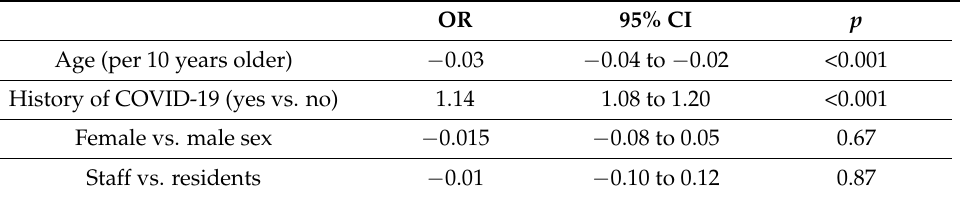
Table 2. Linear regression analysis of factors associated with IgG ‐ S titers (logAU/mL) after vaccina ‐ tion against SARS ‐ CoV ‐ 2.